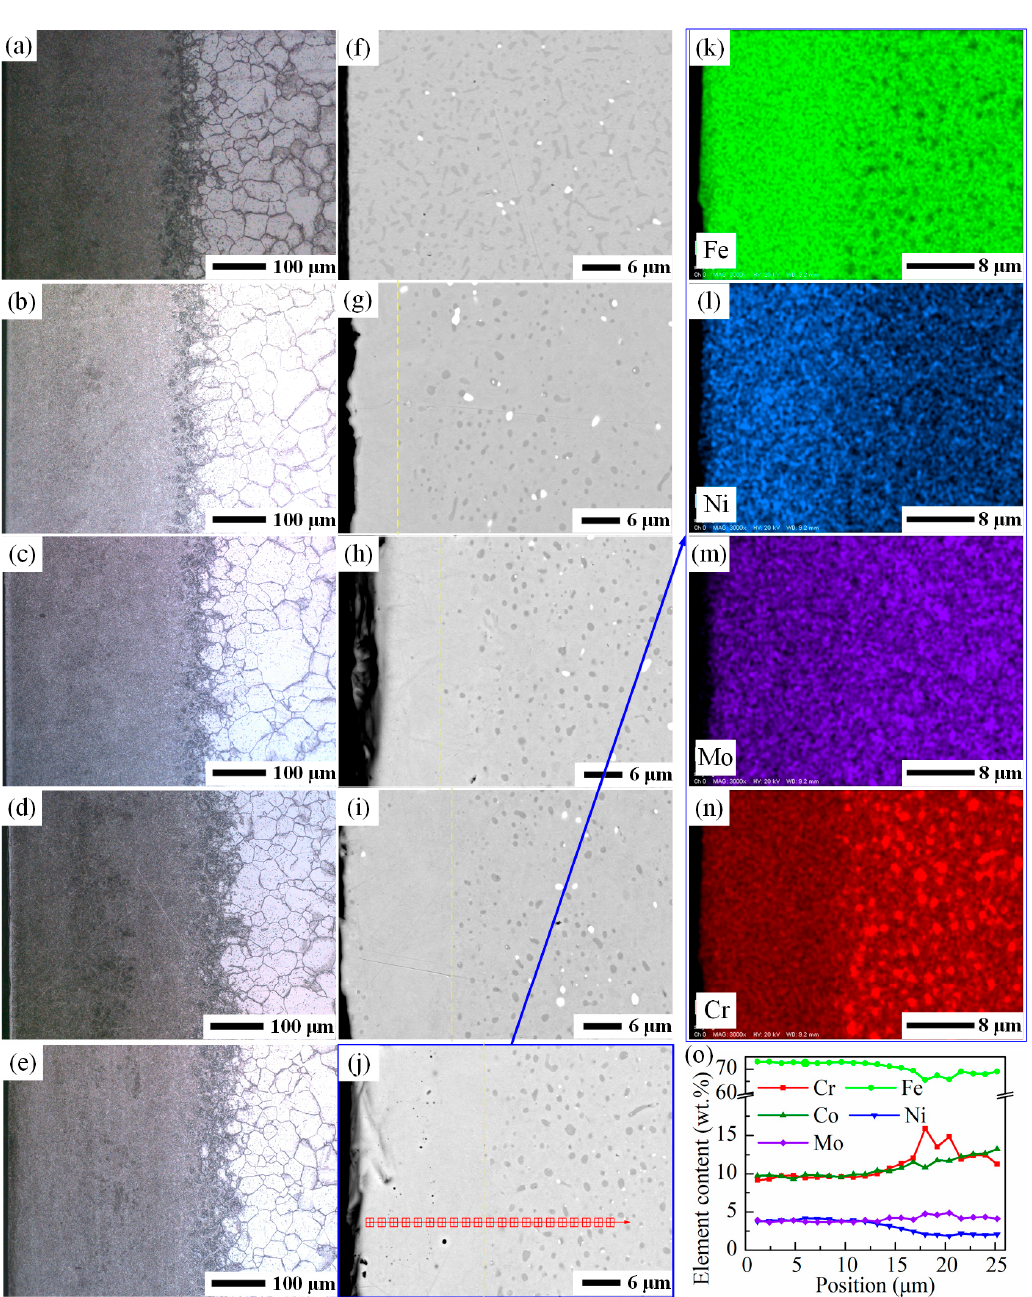
Figure 6. Metallograph of the samples: ( a ) uncoated sample, ( b ) coated 1.4 µ m Fe–Ni film, ( c ) coated 2.4 µ m Fe–Ni film, ( d ) coated 3.8 µ m Fe–Ni film, and ( e ) coated 6.0 µ m Fe–Ni film; backscattered electron images of the samples: ( f ) uncoated sample, ( g ) coated 1.4 µ m Fe–Ni film, ( h ) coated 2.4 µ m Fe–Ni film, ( i ) coated 3.8 µ m Fe–Ni film, and ( j ) coated 6.0 µ m Fe–Ni film; EDS elements map: ( k ) Fe, ( l ) Ni, ( m ) Mo, and ( n ) Cr; ( o ) chemical composition at different locations marked in ( j ) measured by EDS. The red dashed line indicates the depth of the case layer, and the yellow dotted line indicates the width of the carbide-free zone.